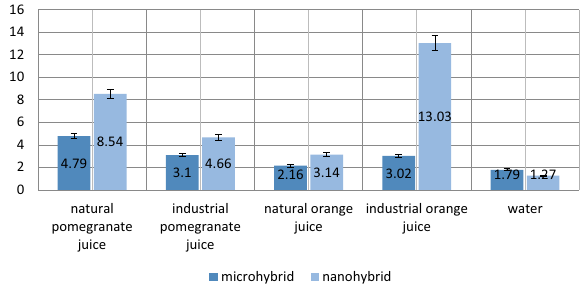
Fig. 3 Mean discoloration of microhybrid and nanohybrid compo- sites exposed to natural and commercially-produced